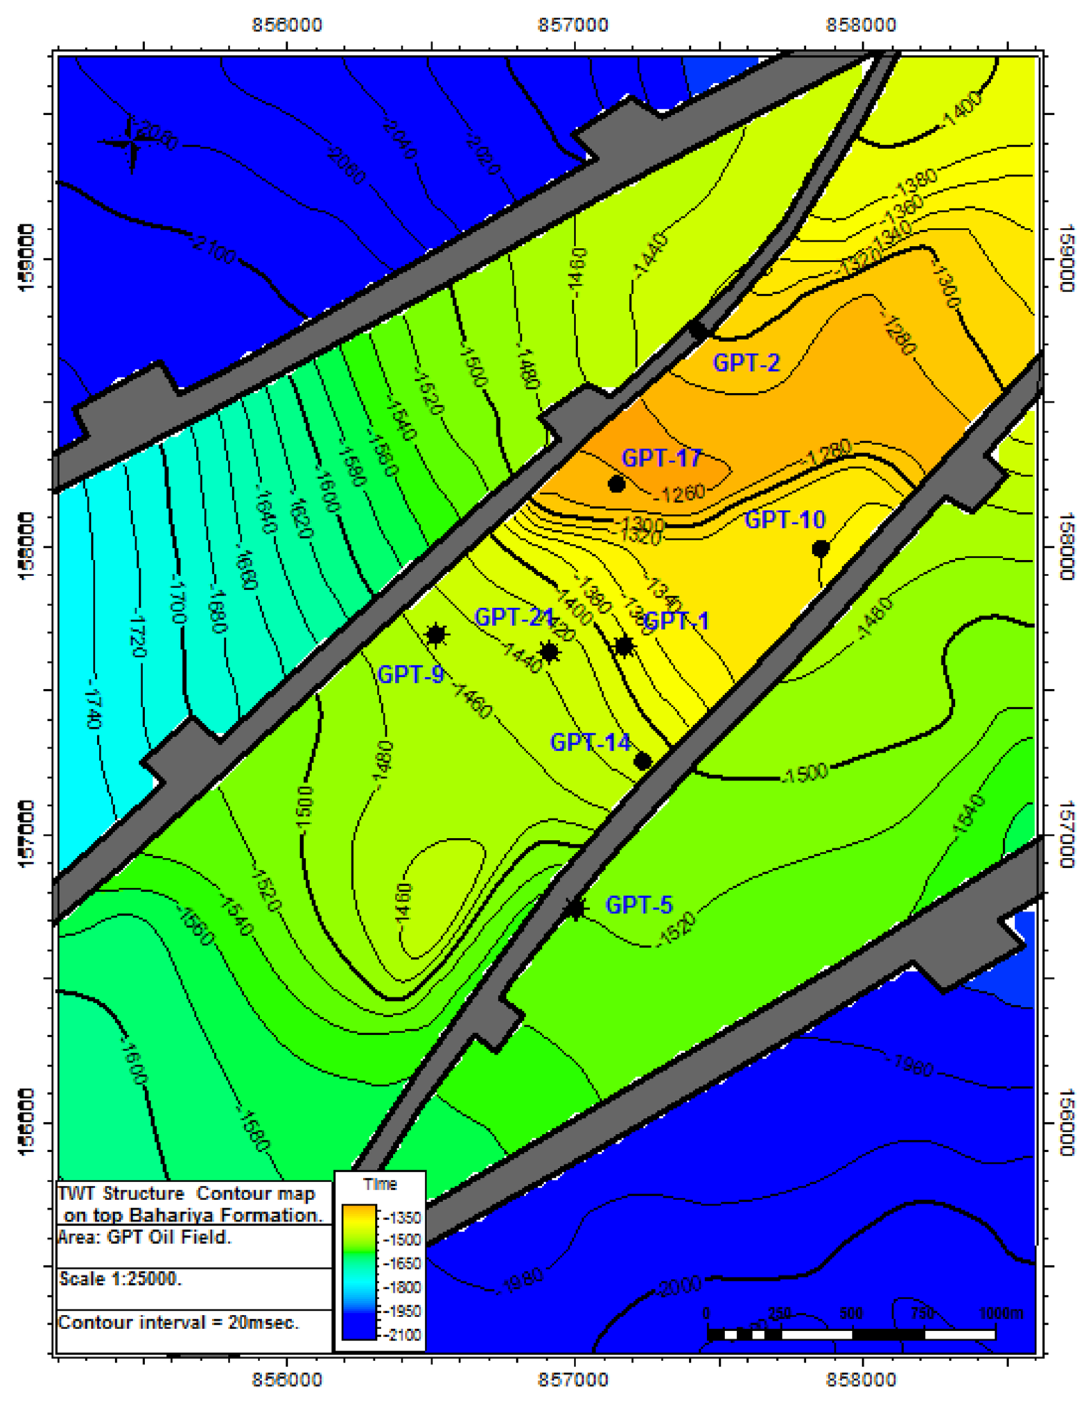
Fig. 6 TWT structure contour map of top Bahariya